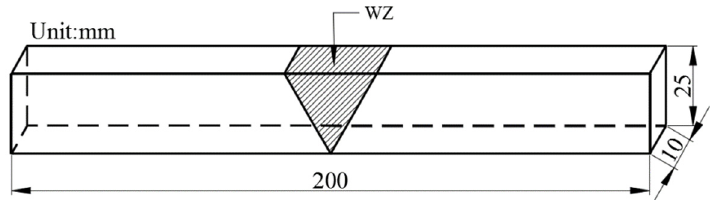
Figure 6. Cut-out dimension of bending specimen. Table 4. Size regulation of bending test.